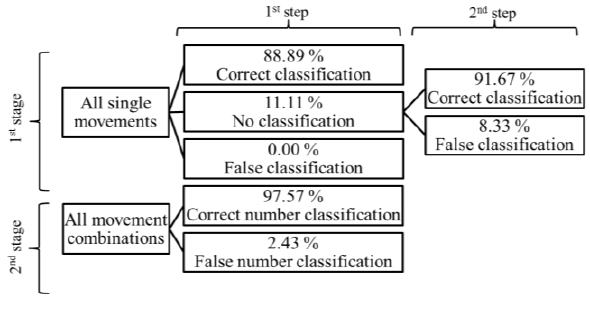
Figure 5 . Stages and steps of the classification.